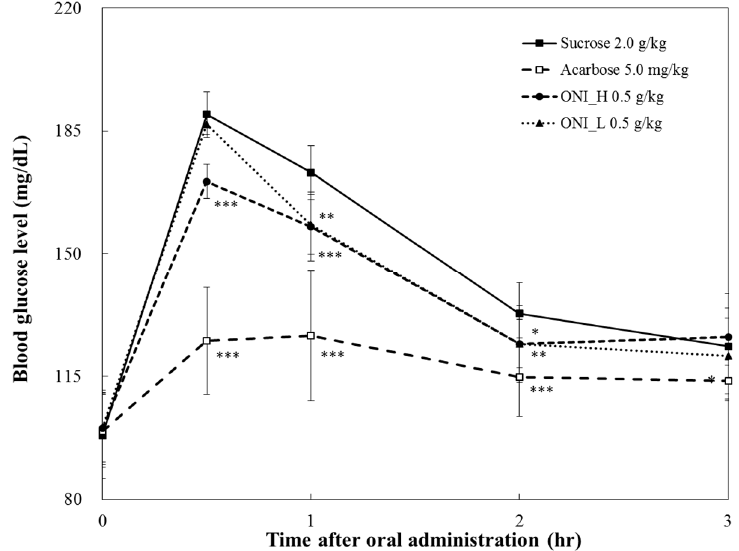
Figure 4. Comparison of postprandial blood glucose-lowering effects of ONI_H and ONI_L in sucrose loading test. After fasting for 24 h, five-week-old, male SD rats were orally administered sucrose solution (2.0 g/kg) with or without samples (onion extracts). The results were expressed as mean ± S.D. Statistical significances were determined by Student’s t -test (* p < 0.05; ** p < 0.01; and *** p < 0.001).